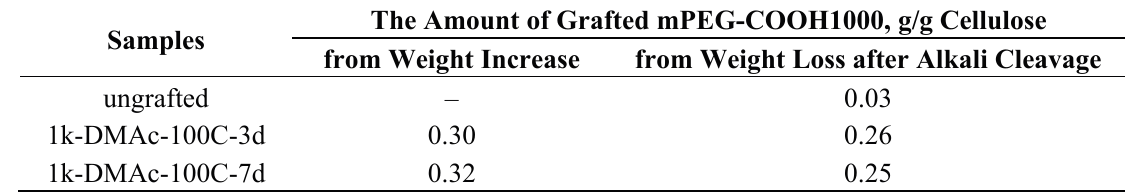
Table 2. The amount of grafted mPEG-COOH1000 in 1k-DMAc-100C-3d and